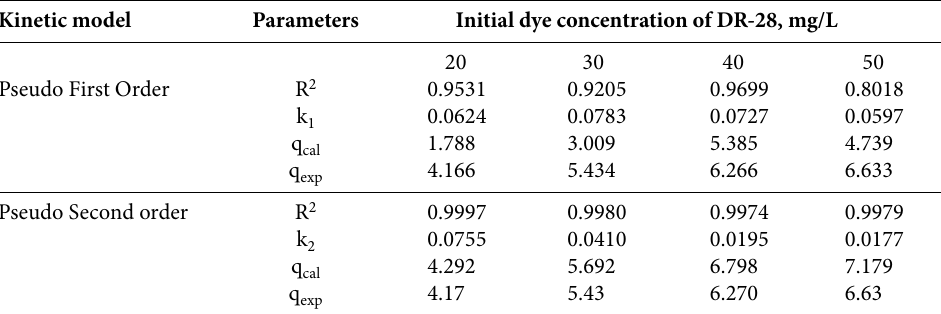
Table 3. Pseudo first order and pseudo second order kinetic model constants for DR-28 adsorption using the ad- sorbent KZF Kinetic model